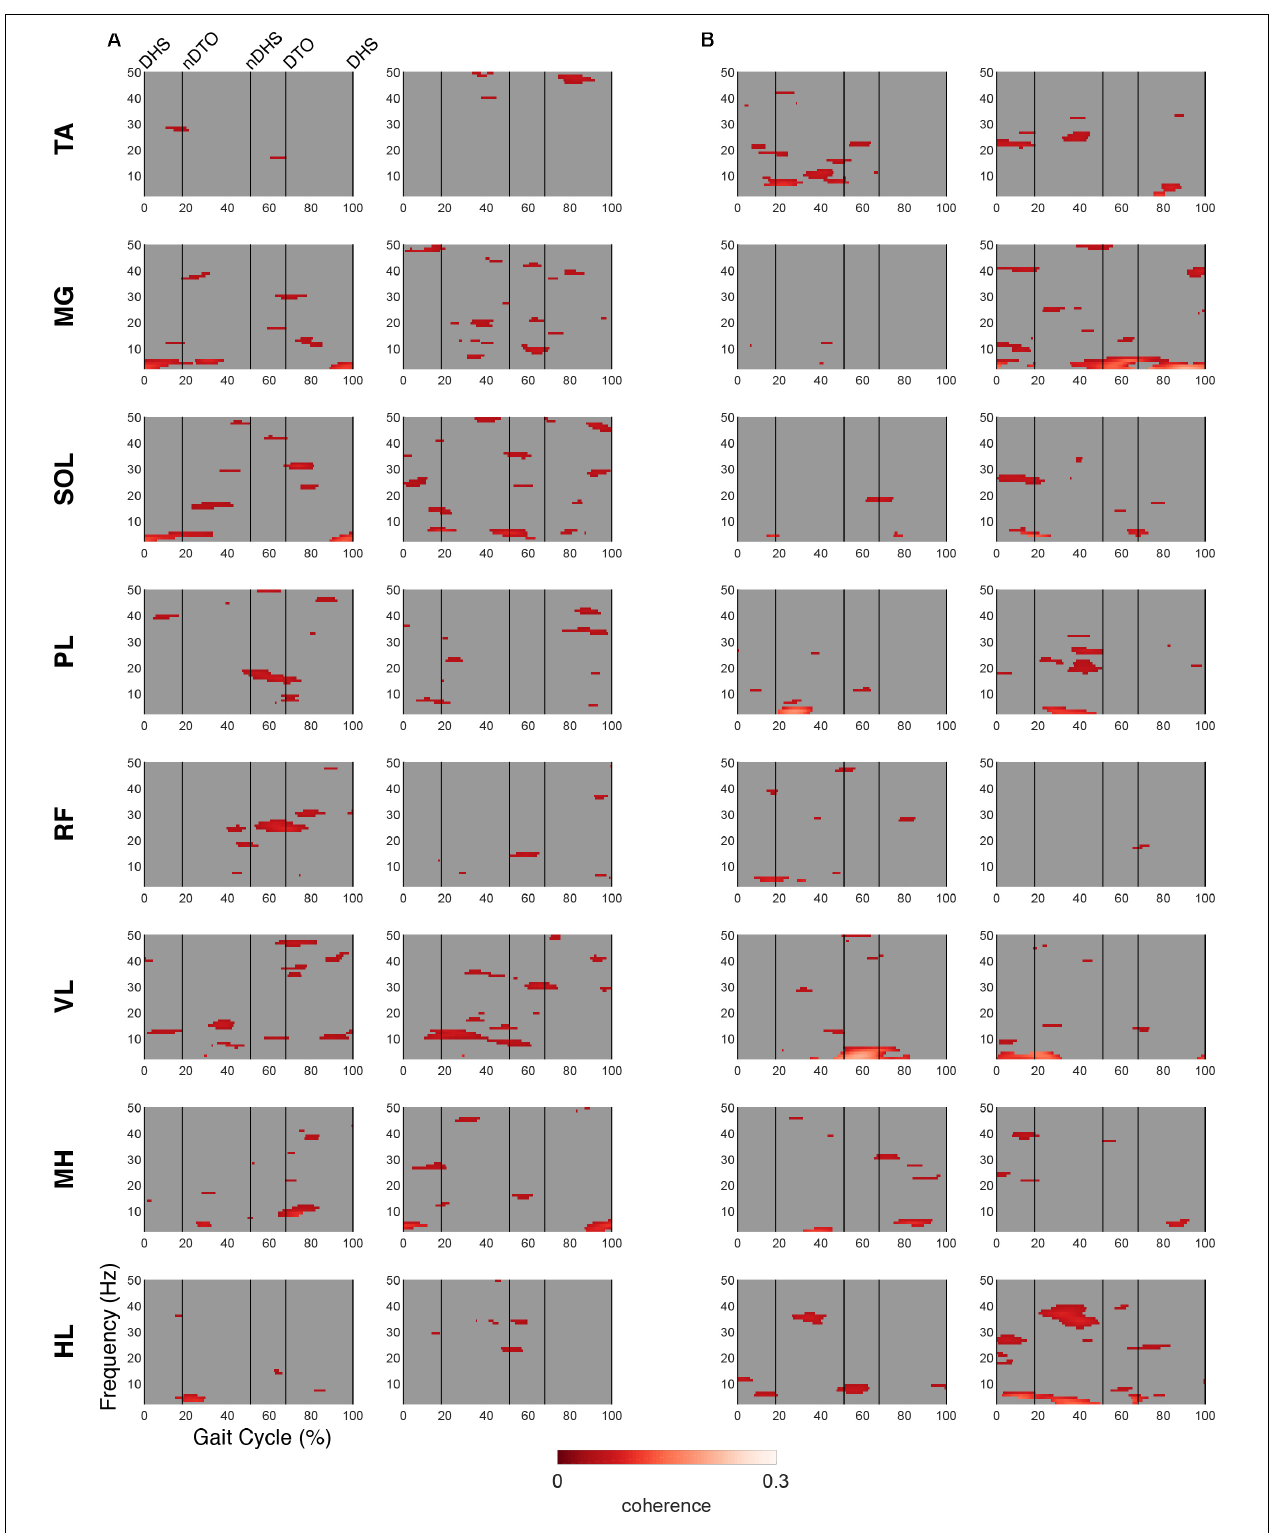
FIGURE 6 | EMG-IC coherence relative to dominant motor clusters. Linear coherence magnitudes between non-dominant (left)/dominant (right) EMG signals and dominant motor IC activations in (A) TD and (B) CP. Coherence plots were masked for significance (alpha < 0.05); non-significant values and time points where EMG signals led IC activations (phase > 0 radians) were set to 0